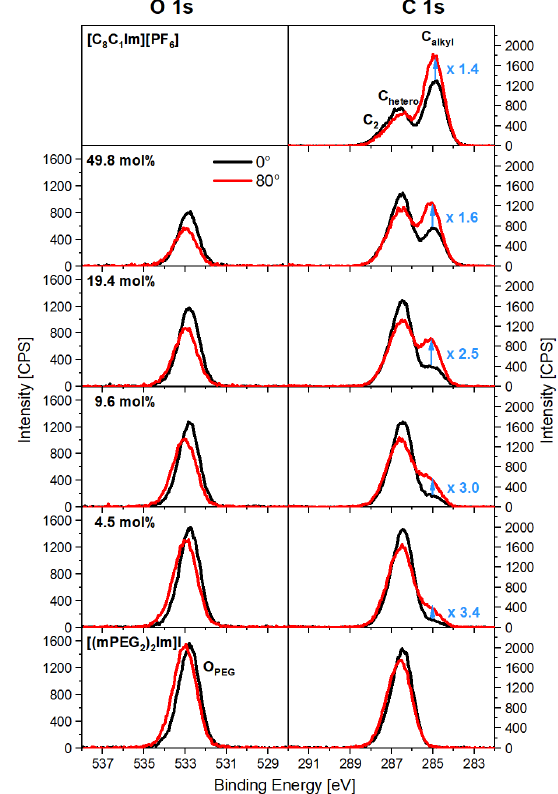
Figure 2. O 1s and C 1s spectra at 0° (black) and 80° (red) emission of pure [C 8 C 1 Im][PF 6 ], pure [(mPEG 2 ) 2 Im]I, and of different mixtures of these ILs, collected at T = 298 K. The relative increase in C alkyl intensity upon changing the emission angle from 0° to 80° is indicated (for details, see text).